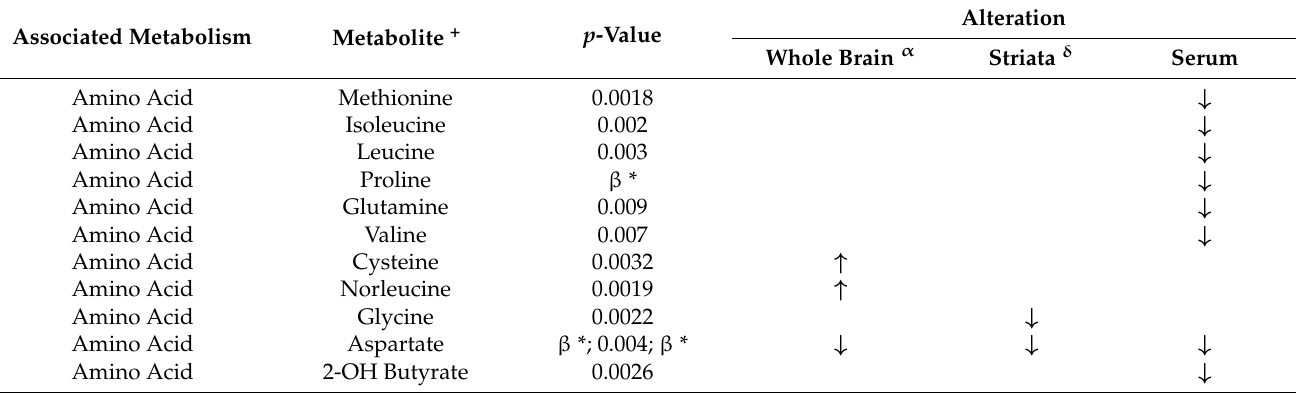
Table 1. Compound 1a ’s metabolic alterations in serum and brain samples ‡ .